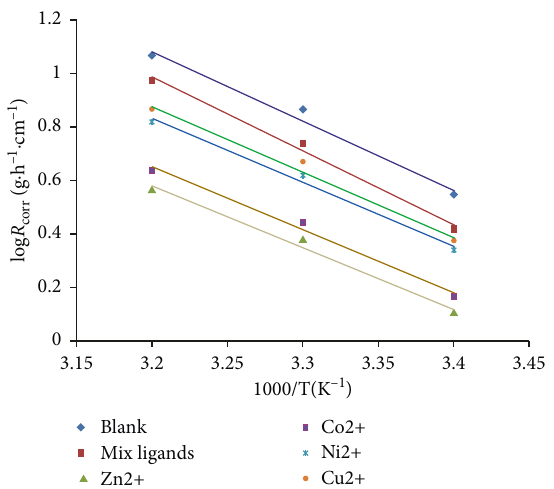
Figure 12: Arrhenius of log corrosion rate ( R × 10 − 2 ML − 1 of inhibitors (mixed corr ) vs 1/ T for aluminum in 1M HCl without and with 0.04 ligands and their metal complexes). Table 9: Thermodynamic parameters for the adsorption of (0.04 × 10 − 2 )M/L mixed ligands and their metal complexes on aluminum metal in aqueous solution of 1M HCl at different temperatures for 7hrs. Compound